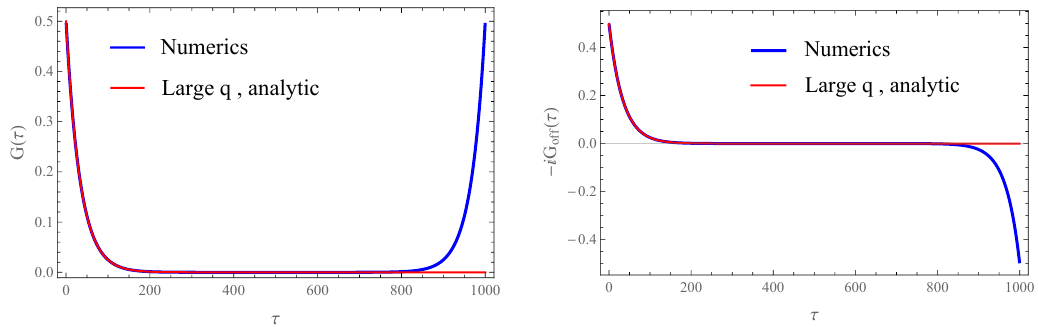
Figure 17 . The plot of Green functions. For the numerical solution of the Schwinger-Dyson equation, we put q = 96, = 1 (cid:22) = 0 : 03 and (cid:12) = J